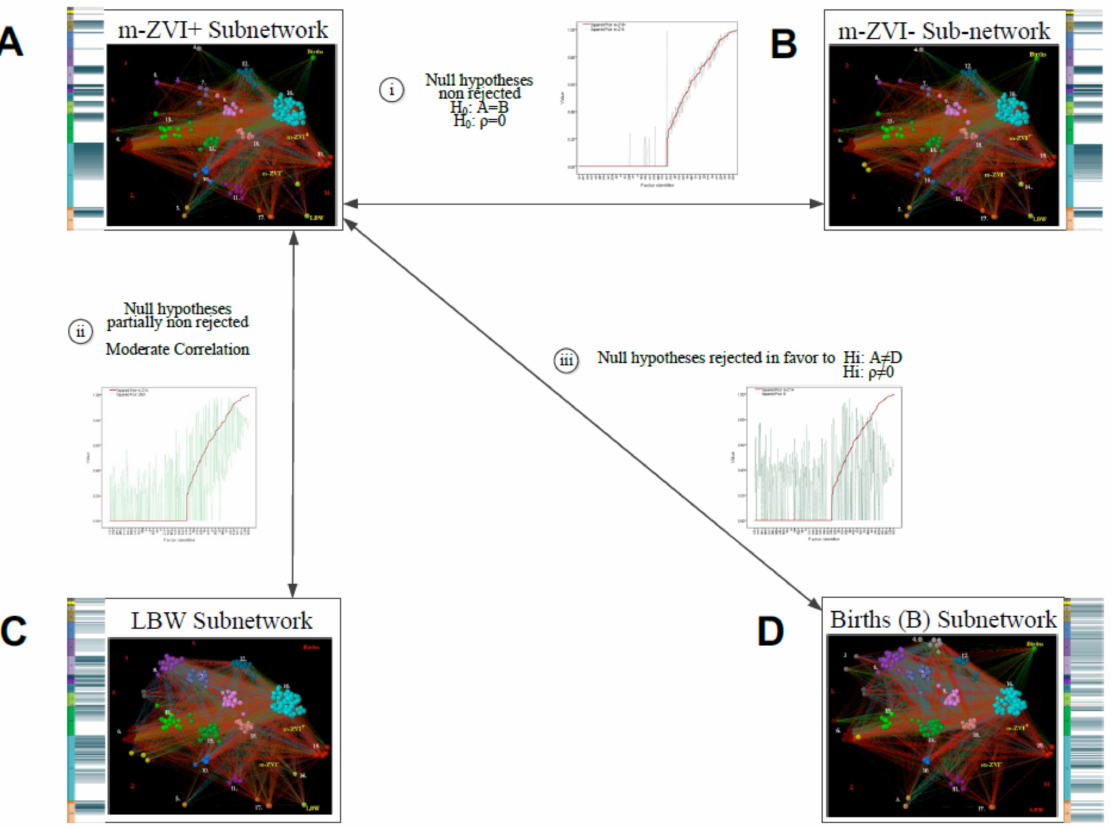
Figure 2. Summary of Statistical Comparisons Between Subnetworks. Boxes show visualizations of each subnetwork structure and fingerprint ( A . m-ZIKV + , B . m-ZIKV − , C . LBW, D . B). Visualizations include colored nodes according to determinants described in Table 1, and links with colors according to pcor association strength (blue: strongest positive, green: strong positive, red: strong negative, dark red: strongest negative). Fingerprints in different shades of teal correspond to pcor 2 values of direct links with each node/variable and case and control nodes. (Darker color bands correspond to stronger links, lighter correspond to weaker links direct links pcor 2 and white corresponds to link absence). Arrows show comparisons between subnetworks: i; comparison between m-ZIKV + and m-ZIKV − subnetworks showed no significant differences of variables, links and weights of links, and solely significant differences of betweenness; ii; comparison between m-ZIKV + and LBW had a partial concordance of networks (0.38), means and medians difference of pcor with similar sizes, and moderate to low concordance of effects (pcor 2 ); and iii; Comparison between m-ZIKV + and B, different for nodes, links and their pcor weights, but some similar effects by pcor 2 . Each line has overlapped distributions according to the ranked pcor 2 of m-ZIKV + (red line) showing the differences with the corresponding pcor 2 of links of aligned nodes in m-ZIKV − (i), LBW (green line in ii) and B (dark green line in iii) subnetworks. Oscillation amplitude of control subnetworks pcor 2 show the smallest differences between m-ZIKV + and m-ZIKV − , moderate differences between m-ZIKV + and LBW, and the biggest differences between m-ZIKV + and B. Flat red line indicates no connections. Additionally, by color bands that were extracted from the corresponding heat map ma- trices of zcor, pcor, and pcor 2 for the full and thresholded subnetworks, we complemented the analysis with the visual profiles, or fingerprints, of the direct connections for each subnetwork (Supplementary Material, Table S2). In pcor 2 bands, the darker blue shade des- ignates high link values, while the lighter shades indicate low link values. The fingerprint bands for zcor are represented by a continuous ascendant spectrum between red, yellow, and green, while the colors of the pcor fingerprint bands follow the same four intervals for positive and negative strong and strongest links, as shown in the network